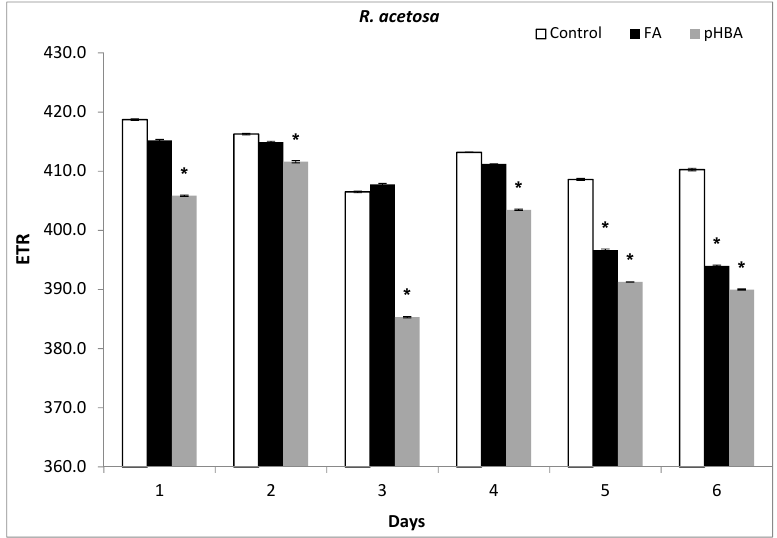
Figure 5. Changes in photosynthetic electron transport rate (ETR) in leaves of Rumex acetosa from days 1 to 6 following exposure to FA and pHBA. Every column in each graph represents the mean (±S.E.) of three replicates. * Asterisks indicate significant differences at p ≤ 0.05 with respect to control.